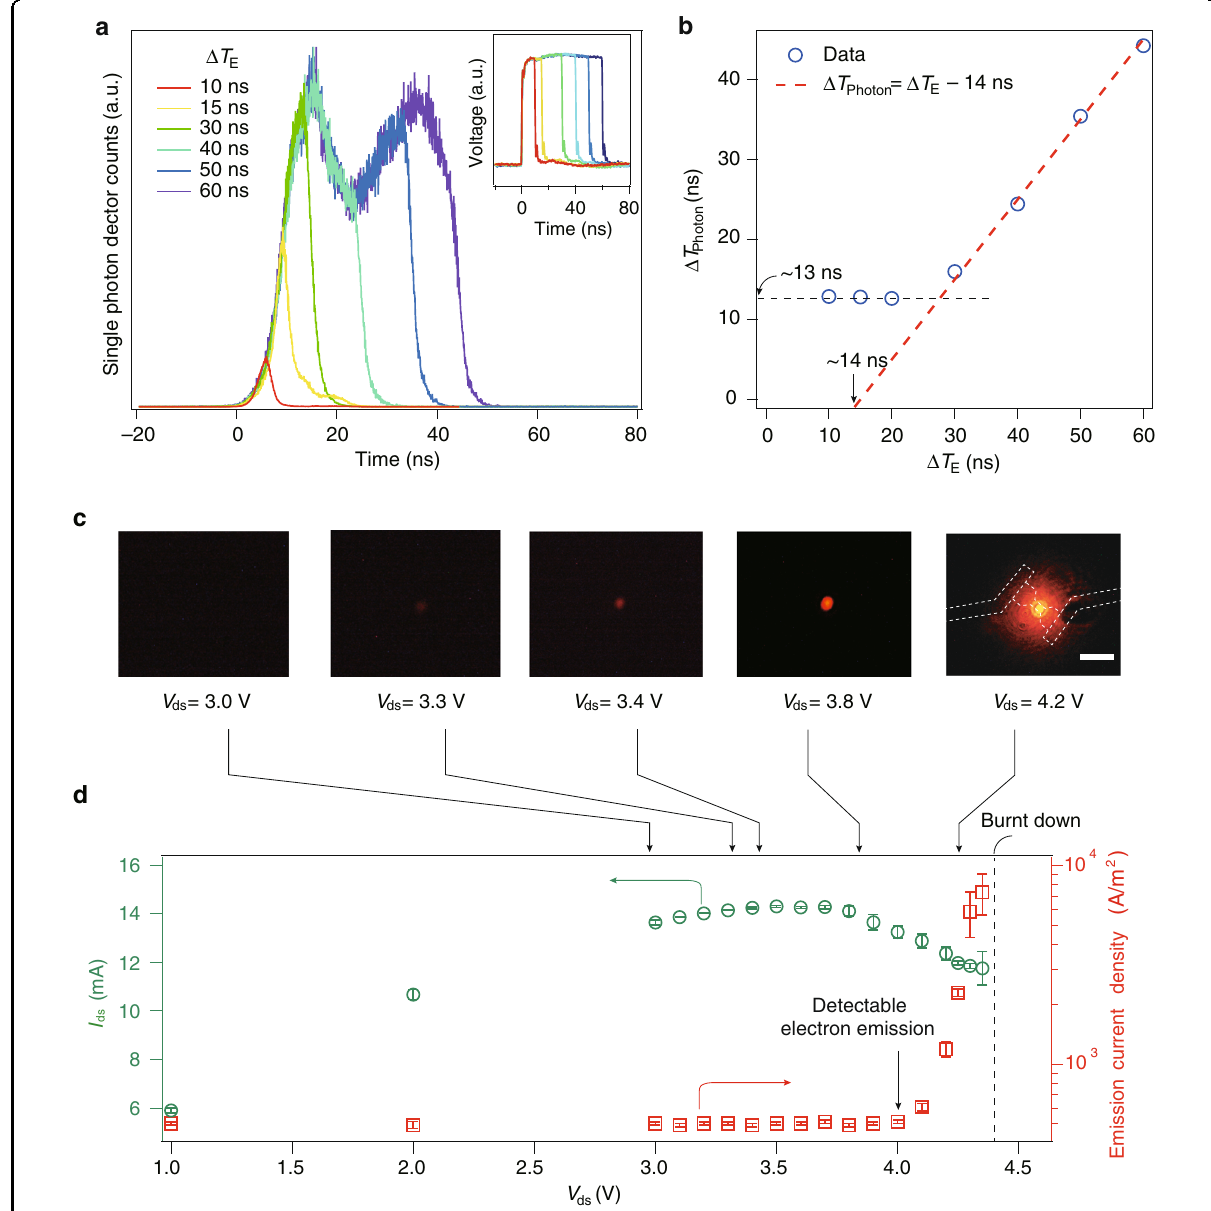
Fig. 4 Dynamics of the vdW NOEMS functioning as ultrafast thermo-radiators. a Typical ultrafast blackbody radiation excited by square electrical pulse sequences with a fi xed repetition rate of 100 kHz ( T = 10 μ s) but various electrical pulse duration Δ T E = 10, 15, 30, 40, 50, and 60 ns, respectively. Inset presents the input voltage signals (electrical voltage pulses of the excitation trace in ns time scale recorded by an oscilloscope) on the tested devices. b Electrical pulse width Δ T E versus the corresponding light-emission pulse width Δ T Photon extracted from ( a ). Dashed lines are linear fi ts. c Optical image captured in the CCD camera at fi xed V ds , showing the status of light emission of the vertical vdW thermionic emission diode. White dashed lines illustrate the top view pro fi le of the emitter. Scale bar = 5 μ m. Data were obtained at 300 K and under a vacuum condition of about 10 − 2 mbar. A collector voltage of + 40 V was maintained throughout the measurements. d Pro fi les of thermionic electron emission I Emission (red squares) and I ds (green circles) as a function of V ds . Error bars represent the fl uctuation of currents recorded during